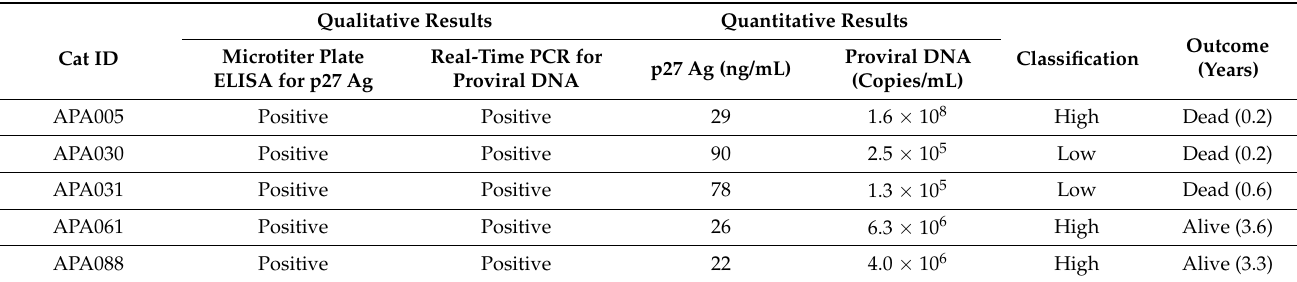
Table 3. At enrollment, five cats with positive qualitative results for both p27 antigen and proviral DNA had quantitative results that were not both above and not both below the determined ROC cutoff values of 37.5 ng/mL of p27 antigen and 4.0 × 10 5 copies/mL of proviral DNA. Classification as high positive or low positive was assigned based upon the quantitative value for copy numbers of proviral